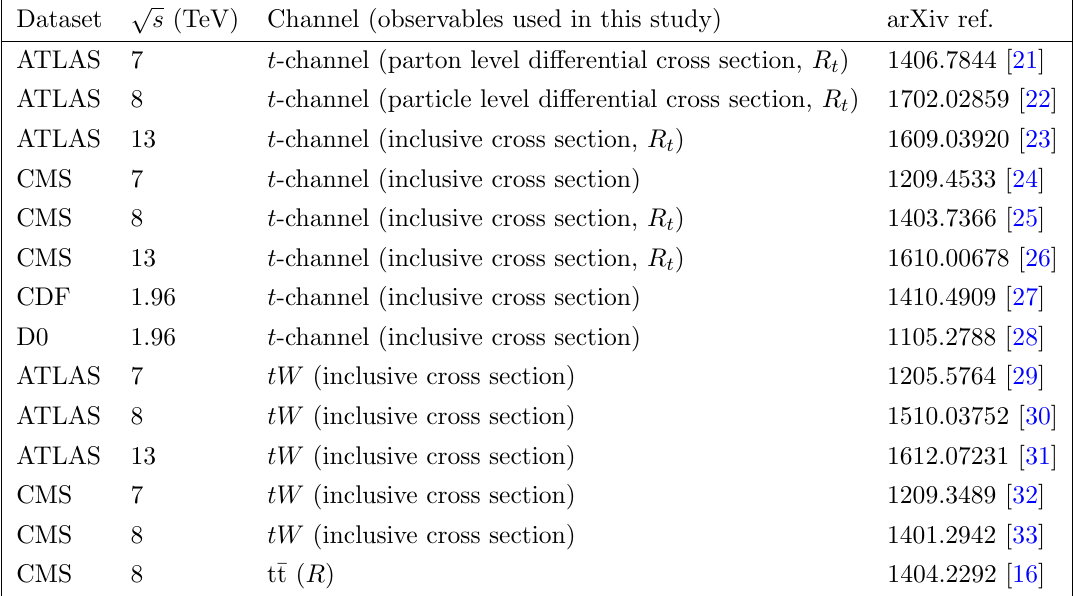
Table 1 . The experimental observables used in this